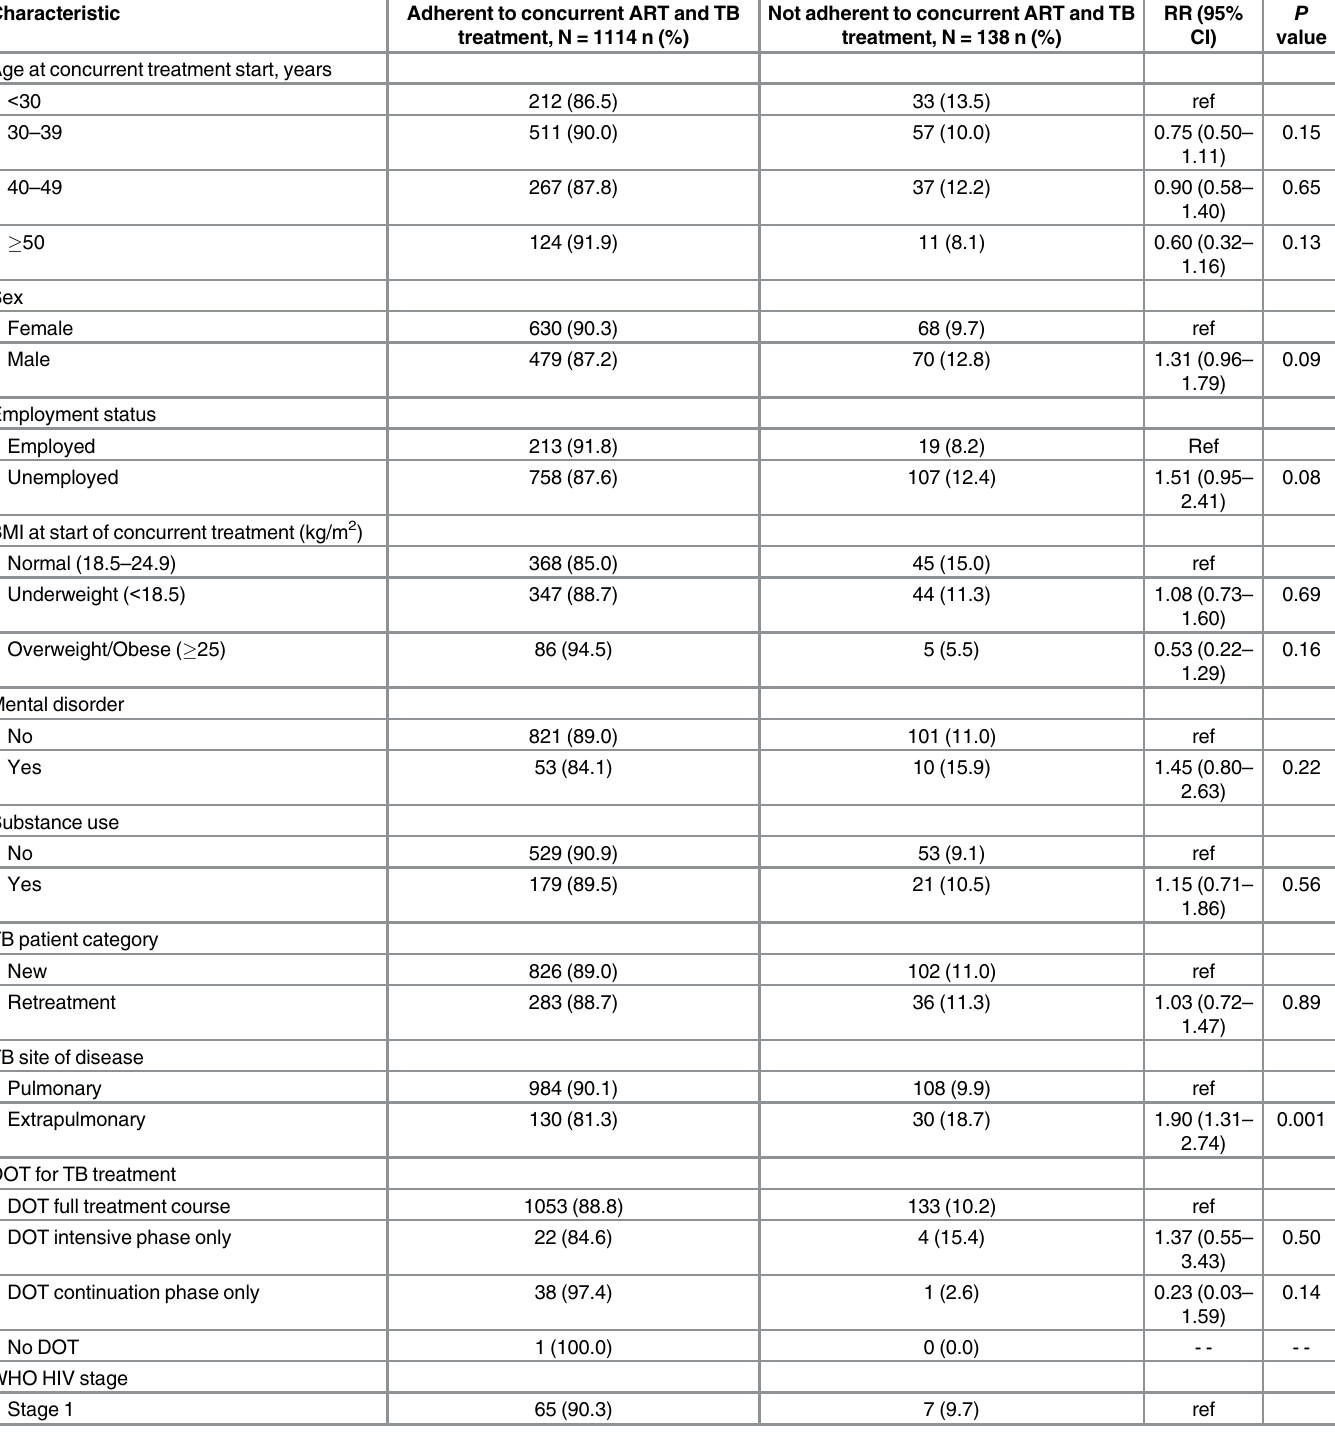
Table 2. Bivariate relationship between characteristics of persons receiving concurrent TB/HIV treatment in selected THAT ’ SIT clinics and adher- ence to treatment (N = 1,252). BMI = body mass index; TB = tuberculosis; HRZE = isoniazid, rifampin, pyrazinamide, ethambutol; HRZES = isoniazid, rifam- pin, pyrazinamide, ethambutol, streptomycin; DOT = directly observed therapy; WHO = World Health Organization; HIV = human immunodeficiency virus; ARV = antiretroviral; D4T/3TC/EFV = stavudine, lamivudine, efavirenz; D4T/3TC/NVP = stavudine, lamivudine,